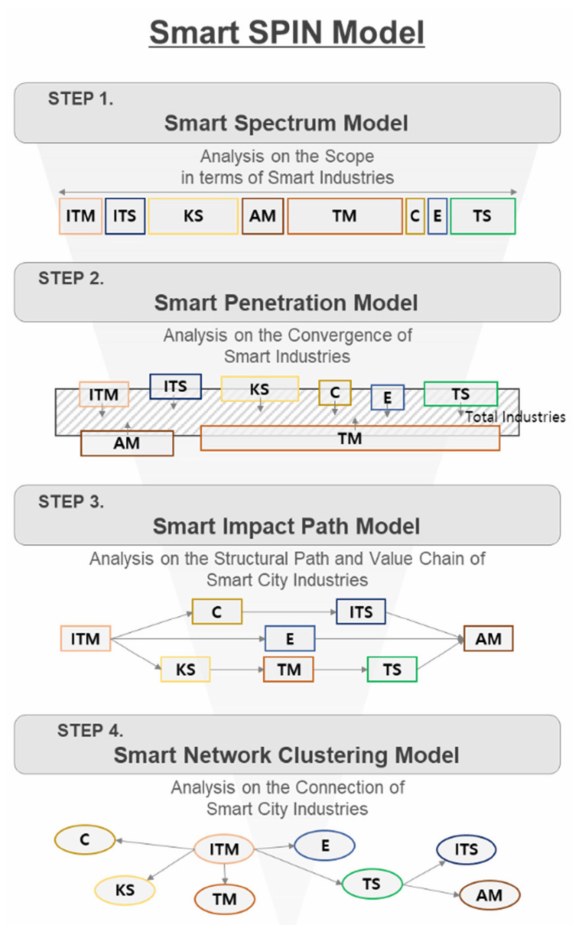
Figure 2. Concept of the smart SPIN